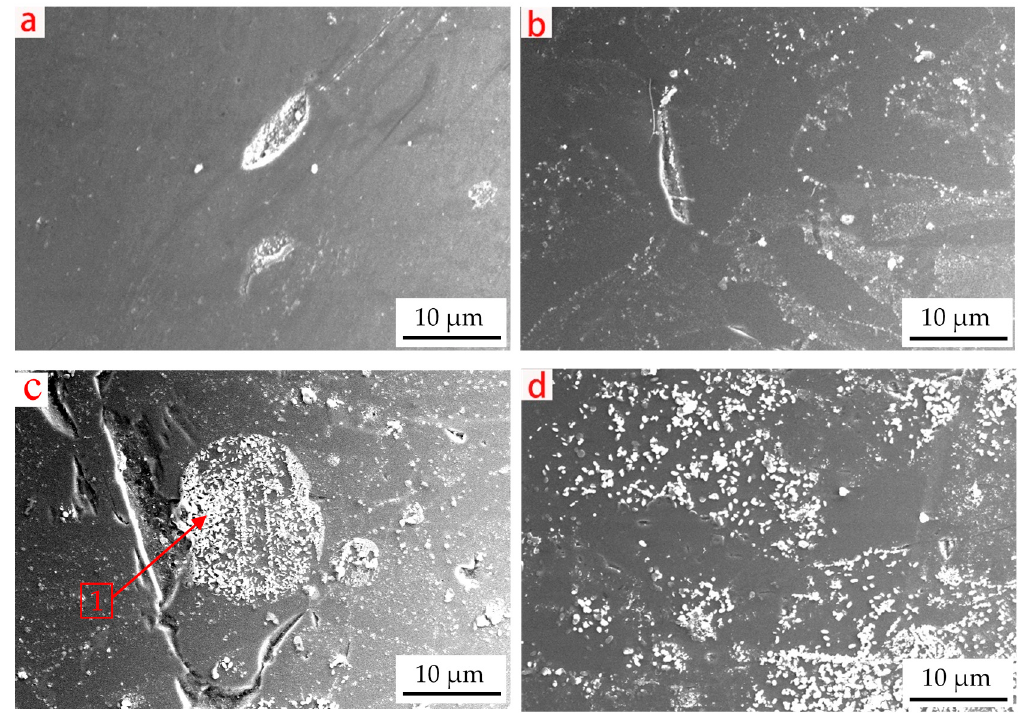
Figure 13. Surface micromorphology of the slags with different contents of UPC: ( a ) 0.6 wt% UPC, ( b ) 0.8 wt% UPC, ( c ) 2 wt% UPC and ( d ) 4 wt% UPC.